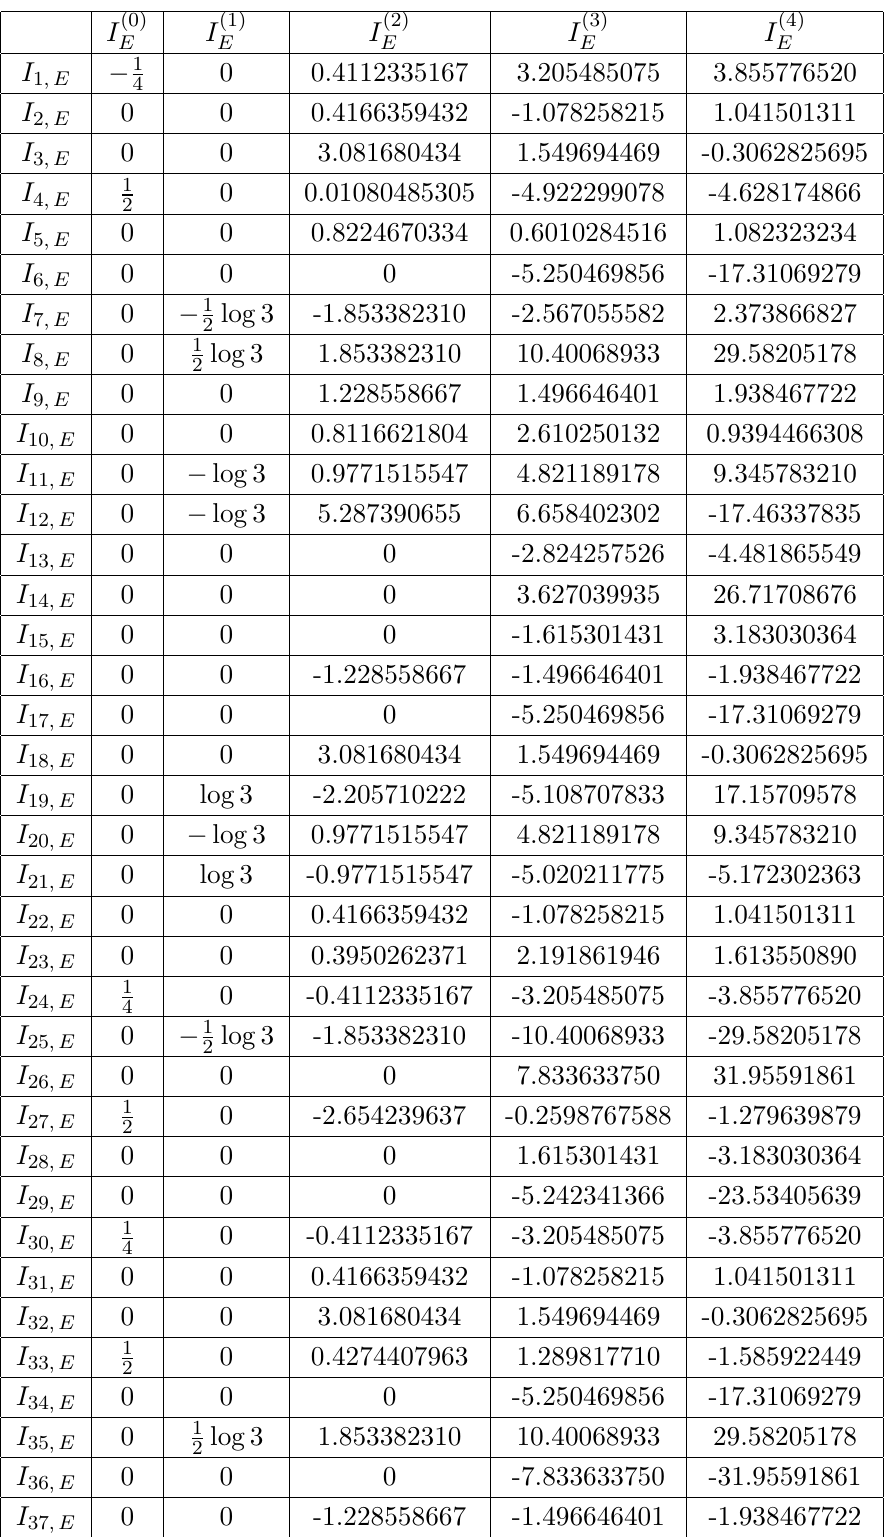
Table 1 . Numerical expressions for the boundary values (integrals from 1 to